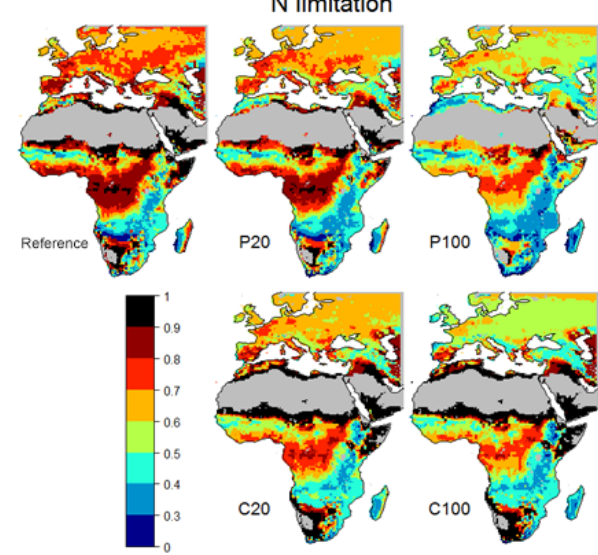
Figure 4. Average net N mineralization rates (kgNha − 1 yr − 1 ) in the soil for the reference simulation (full simulation period) and during the first 100 years of regrowth for the P20, P100, C20, and C100 simulations.